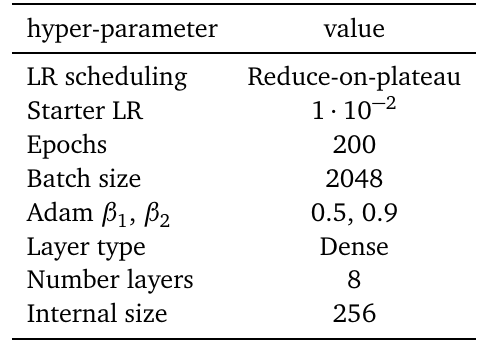
Table 2: Training setup and hyperparameters for the